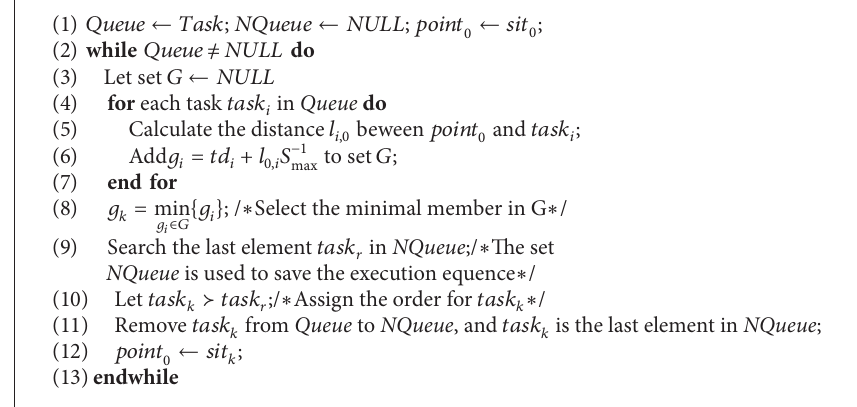
Algorithm 1: Pseudocode of OSR algorithm.